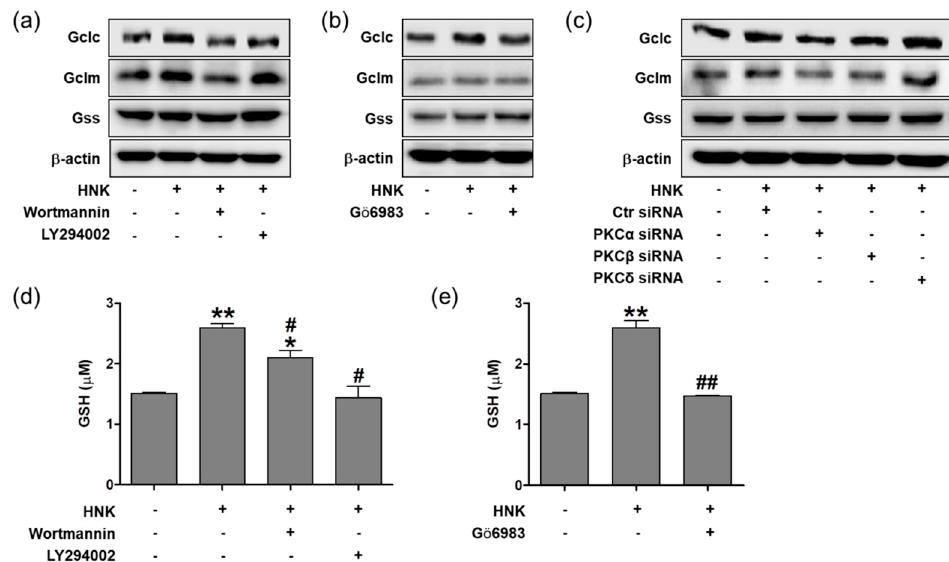
Figure 5. Honokiol regulates the biosynthesis of GSH through PI3K / Akt and PKC signaling pathway in HK-2 cells. ( a , b ) Cells were treated with inhibitors of Wortmannin (100 nM), LY294002 (10 µ M), or Gö6983 (10 nM) for 30 min prior to honokiol (2 µ M). After 12 h incubation, the cell lysates were subjected to Western blot analysis using anti-Gclc, anti-Gclm, anti-Gss, or anti- β -actin antibodies. ( c ) Cells were transiently transfected with specific RNAi for PKC α , PKC β , or PKC δ , or control siRNA (100 nM) for 24 h, and then treated with honokiol (2 µ M) for 12 h. The cell lysates were subjected to Western blot analysis using anti-Gclc, anti-Gclm, anti-Gss, or anti- β -actin antibodies. ( d , e ) Cells were treated with inhibitors of Wortmannin (100 nM), LY294002 (10 µ M), or Gö6983 (10 nM) for 30 min prior to honokiol (2 µ M). After 24 h incubation, the GSH levels were measured. Values are expressed as the means ± S.E.M. of three independent experiments. * p < 0.05, ** p < 0.01 significant compared with the vehicle control. # p < 0.05, ## p < 0.01 significant compared with honokiol alone.